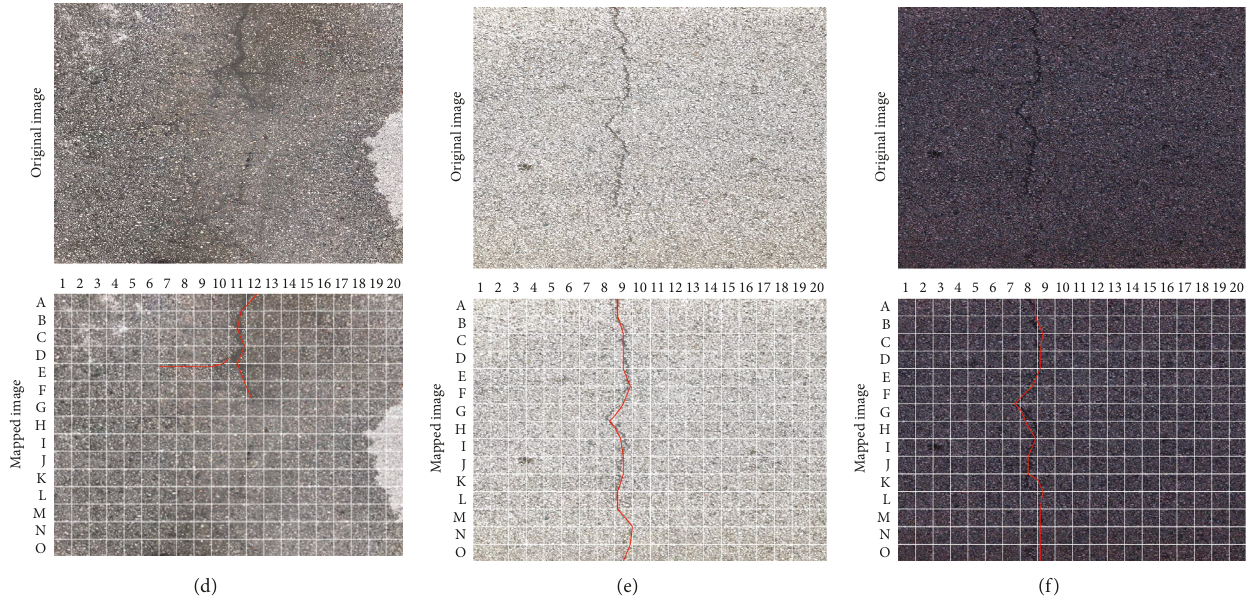
Figure 16: Performance of the algorithm on multiple cracks under different conditions (a), (b), (c), and (d) wet, (e) bright, and (f)